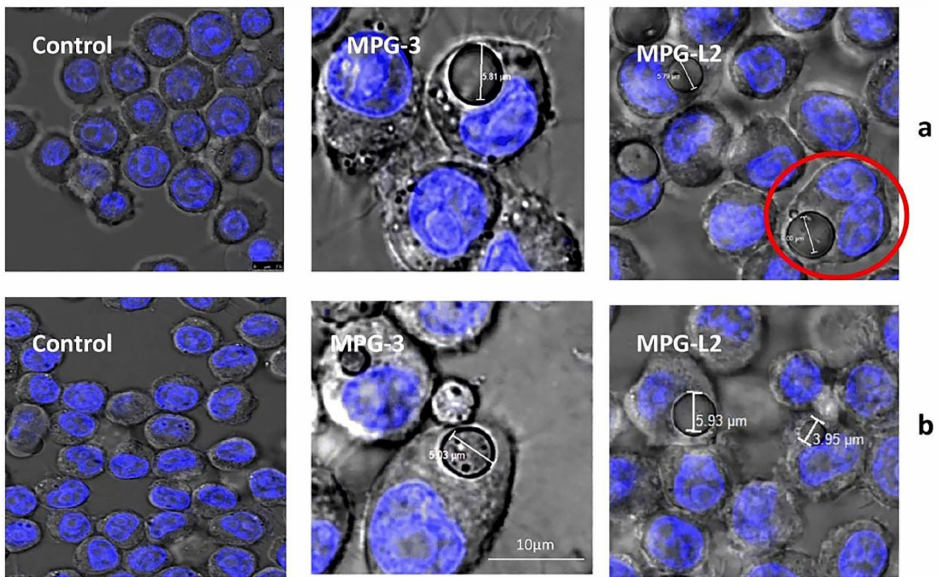
Figure 5. Phagocytosis of MPs by macrophages at 24 h ( a ) and 48 h ( b ). The red circles indicate that MPs do not influence macrophages to replicate while inside the cell [57]. Copyright 2020, Springer